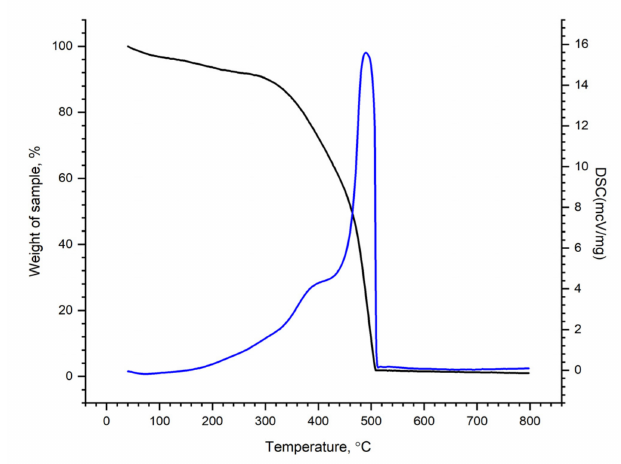
Figure 3. TG-DSC-curve of the r-GO/o-CNTs/PANI nanocomposite cryogel.